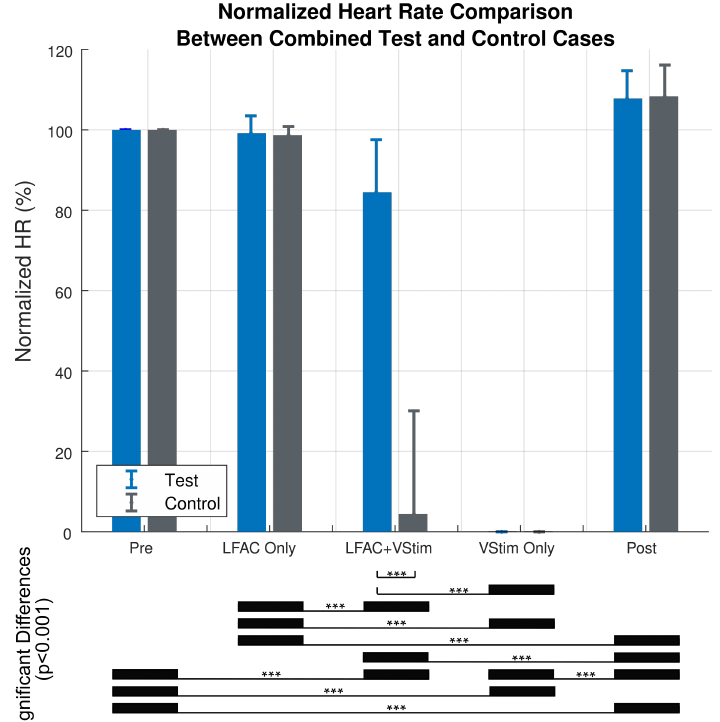
Figure 7. Summary of the normalized heart rate versus treatment for the Test (N = 41) and Control (N = 23) cases. The two-way ANOVA revealed a significant difference due to exper- − 16 imental case (F(1,310) = 229.6, Pr(>F) = 2 × 10 ), a significant difference due to treatment − 16 (F(4,310) = 1607.5, Pr (>F) = 2 × 10 ), and a significant difference between experimental case − 16 and treatment (F(4,310) = 229.8, Pr(>F) = 2 × 10 ). There were no significant differences in the ‘Pre’ vs. ’LFACb Only’ epoch between and within the control and test cases (Tukey post hoc). However, there was a significant difference in the ‘LFACb+VStim’ epoch between the control and test (p-adjusted = 0). The error bars indicate standard deviations. *** Indicates significant differences − 16 ( p = 2 × 10